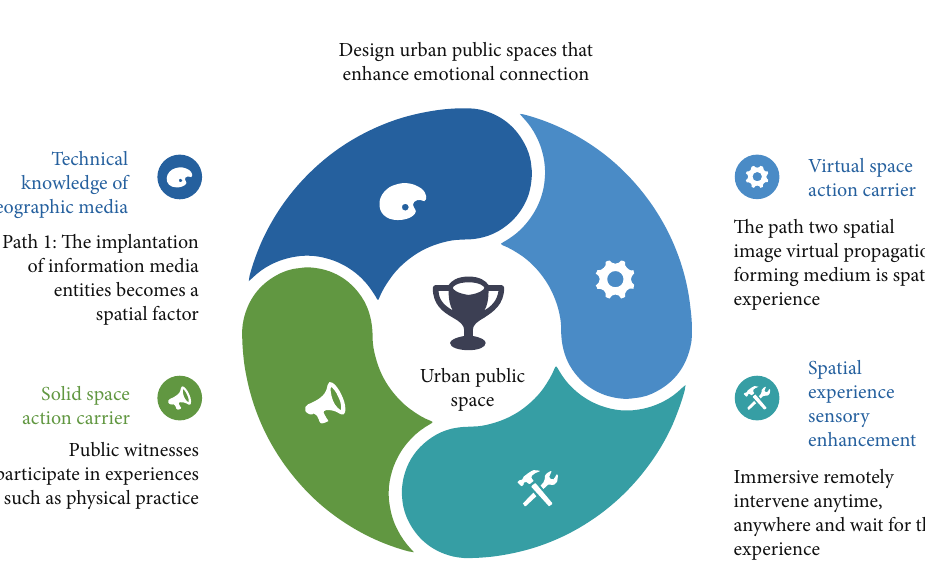
Figure 1: Analysis of rural development with pastoral characteristics under the rural revitalization strategy.